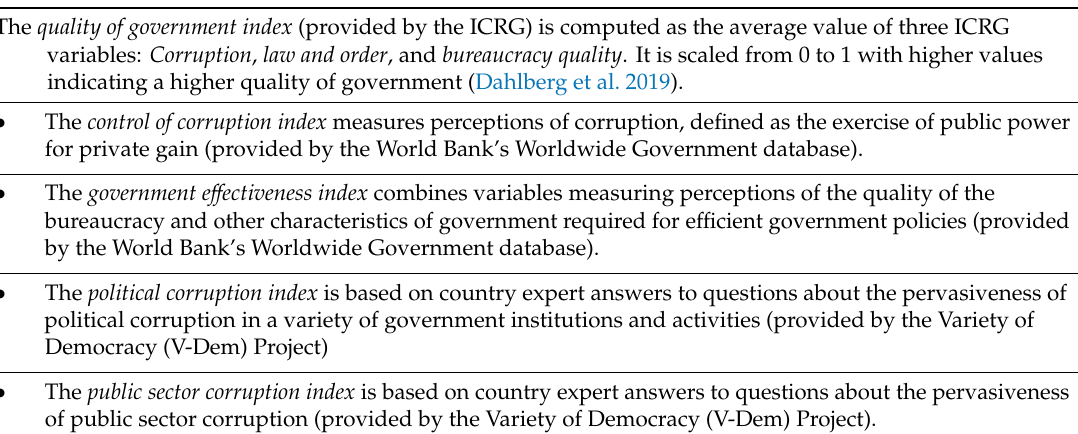
Table A4. Brief descriptions of the five dependent variables used in the analysis. The quality of government index (provided by the ICRG) is computed as the average value of three ICRG variables: Corruption , law and order , and bureaucracy quality . It is scaled from 0 to 1 with higher values indicating a higher quality of government (Dahlberg et al.